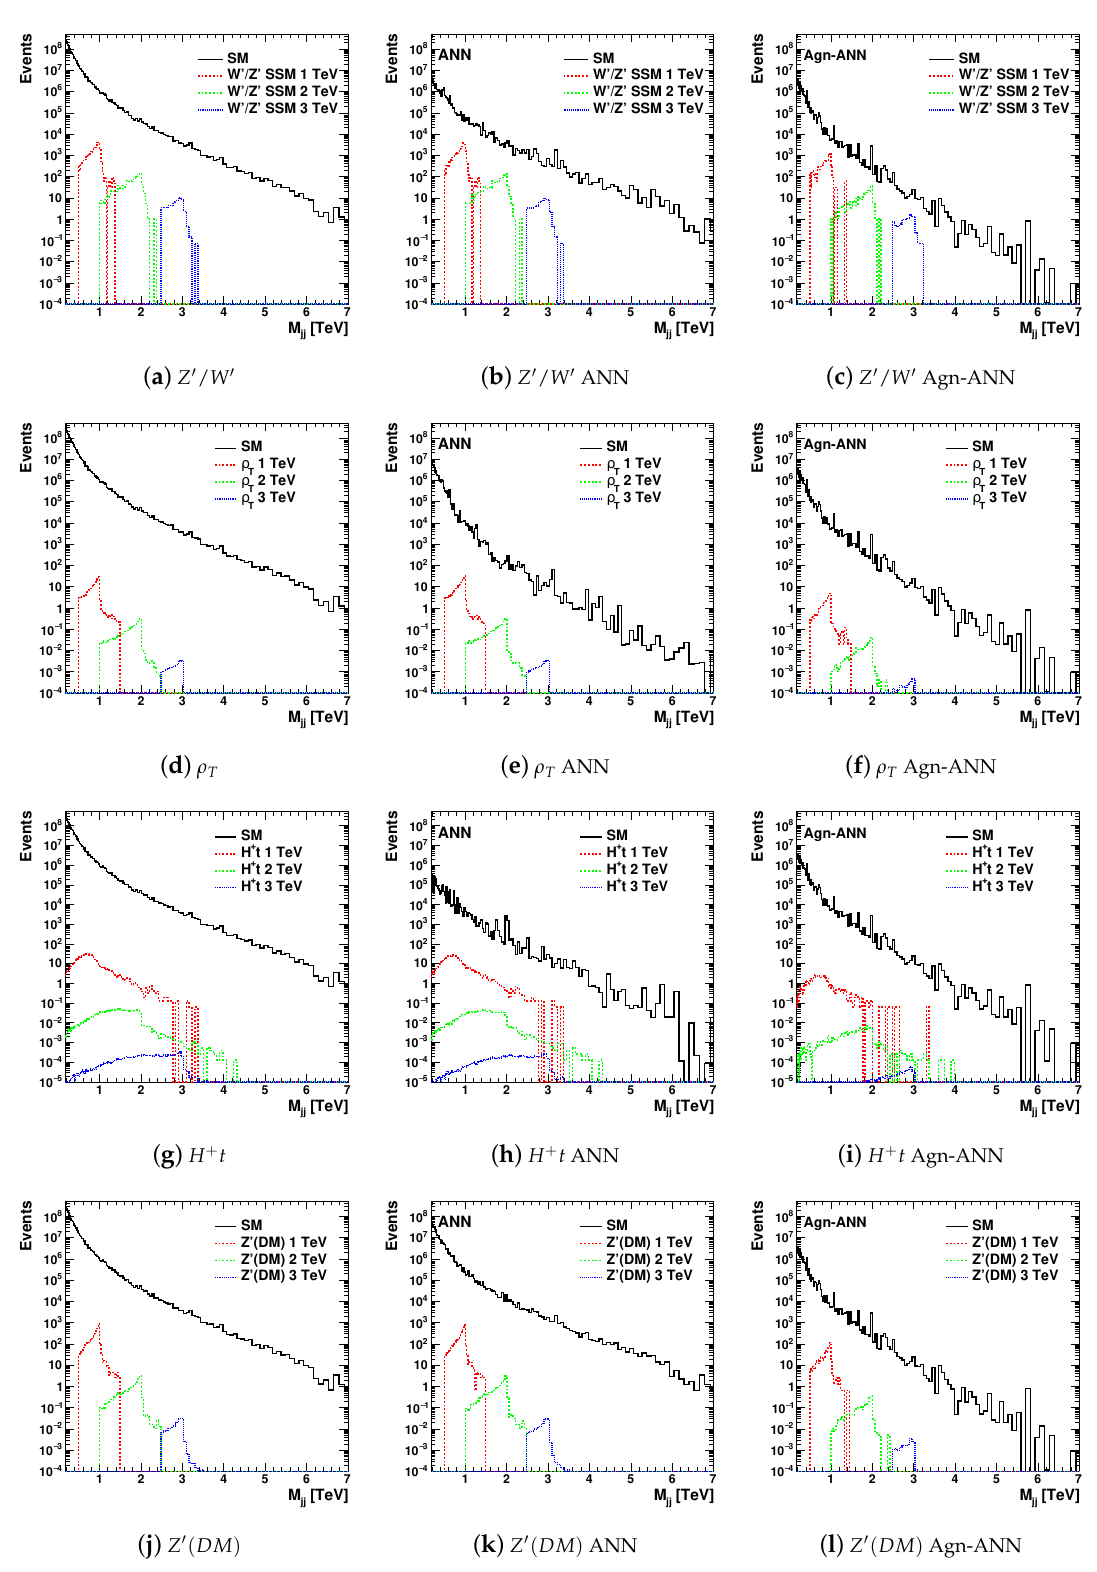
√ s = 13 TeV for the background and BSM models (shown Figure 5. The M jj distributions for 150 fb − 1 of pp collisions at for three representative masses of heavy particles) before and after applying the RMM–ANN selections. ( b , e , h , k ) use a cut on the ANN scores for the BSM output nodes. ( c , f , i , l ) show a model-independent selection that does not use BSM events for the ANN